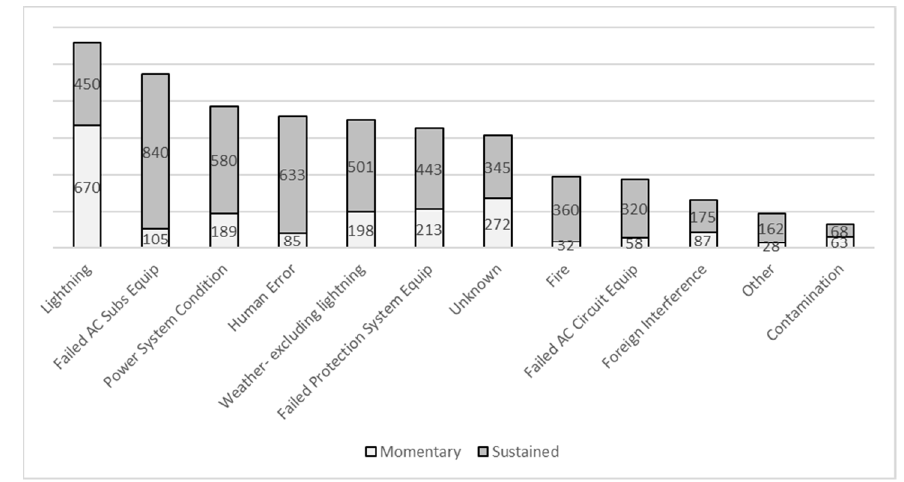
Figure 2. Outages in clusters by initiating cause (2013–2019).